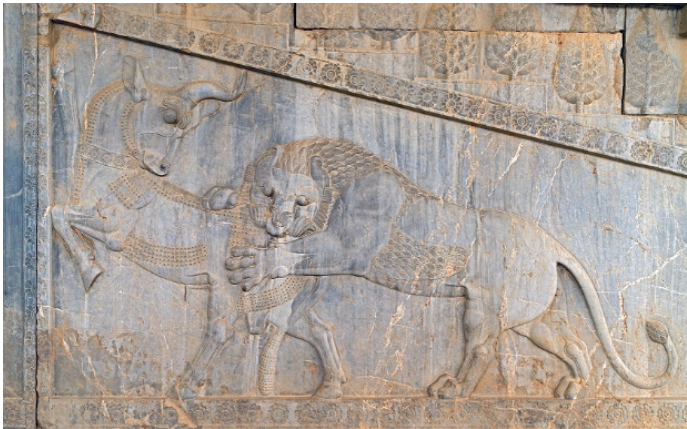
Figure 20. Lion attacking bull; relief panel; Apadana, Persepolis, Persia (mod. Iran); Achaemenid, ca. 518–486 BCE [photography by Janos Rautonen; courtesy of Shutterstock].